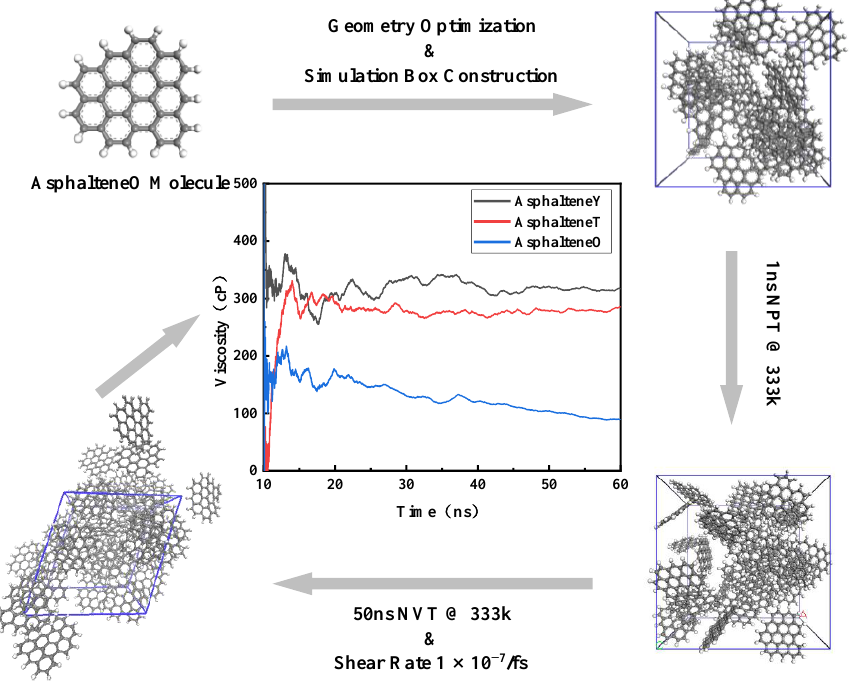
AsphalteneO Molecule